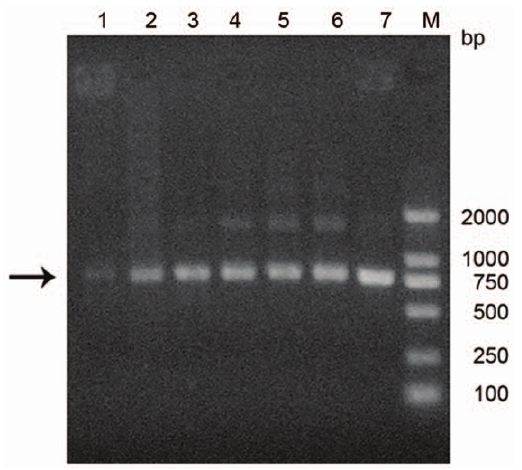
Figure 3. Selection and amplification of anti-DES scFv gene over seven rounds of ribosome display. After selection, the eluted RNA was amplified by RT-PCR and the products were analyzed by agarose gel electrophoresis. Lane M: D2000 DNA marker, lane 1–7: recovered band from the first to seventh selected library of ribosome display. Arrow indicates scFv DNA fragments position.